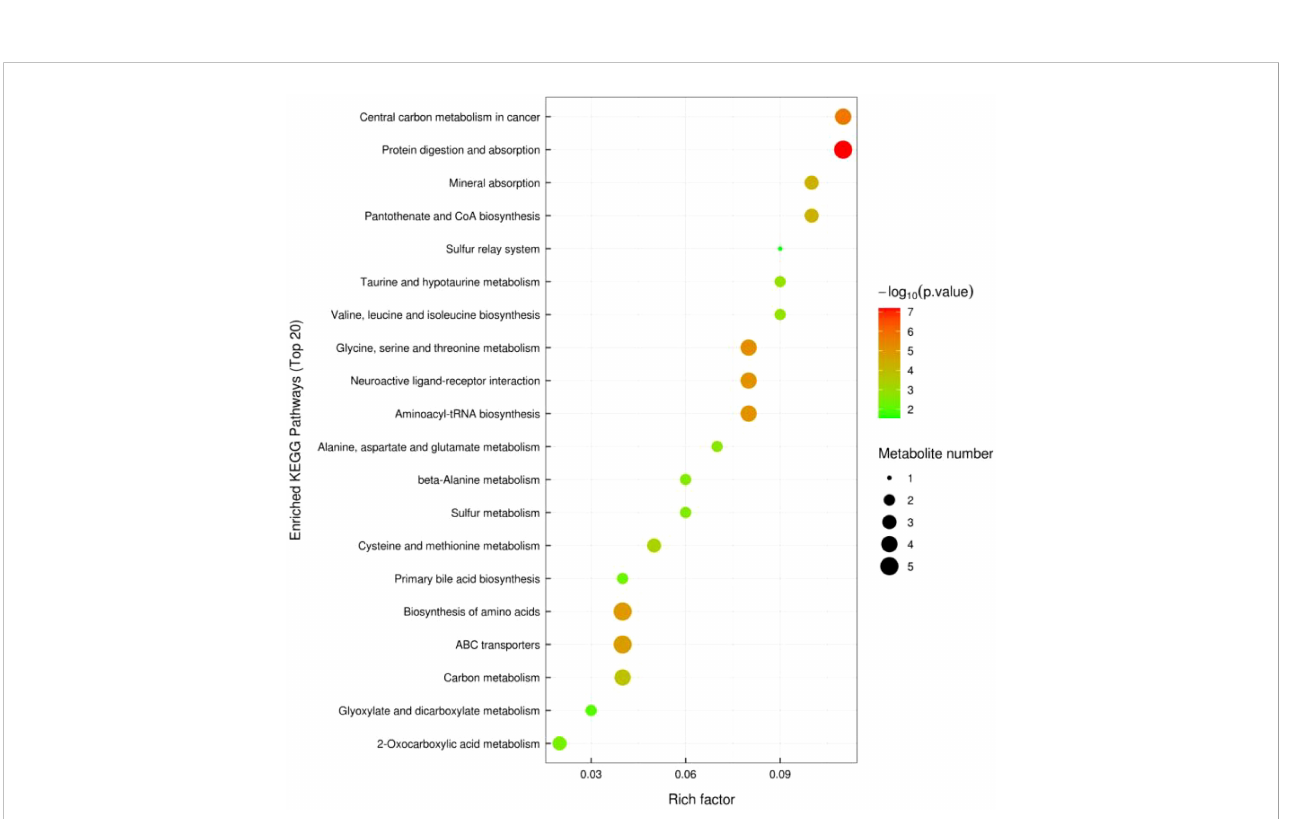
FIGURE 11 KEGG Enriched Pathway Plot (Bubble Plot) for Treatment vs